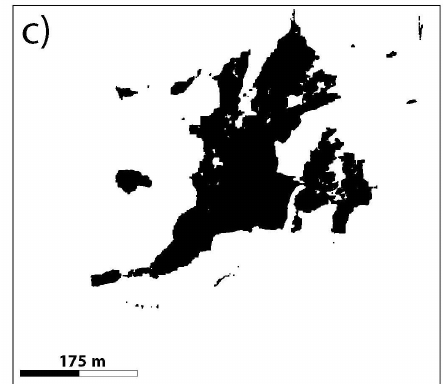
Fig. 8. (a) Pre-event image (11 August 2005) of an area on the south-eastern slope of Balakot (Khwas Katha). (b) Post-event im- age (19 October 2005) of the same area where a large landslide area is contoured by a green line as detected by visual inspection. Red triangles point to a possible deformed area. (c) Landslide (black area) occurring in the area detected by the automatic